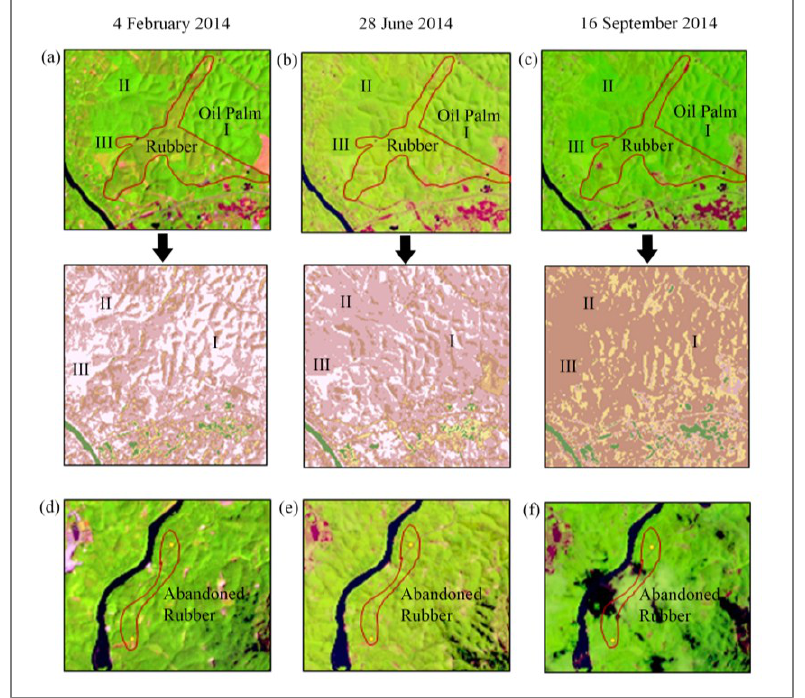
Figure 6. Multi-temporal Landsat OLI imagery used to choose the right satellite image in discriminate between non-abandoned rubber and oil palm; ( a ) images dated as 4 February 2014; ( b ) images dated as 28 June 2014; ( c ) images dated as 16 September 2014; and abandoned rubber appear permanently green using time series image ( d ) images dated as 4 February 2014; ( e ) images dated as 28 June 2014; ( f ) images dated as 16 September